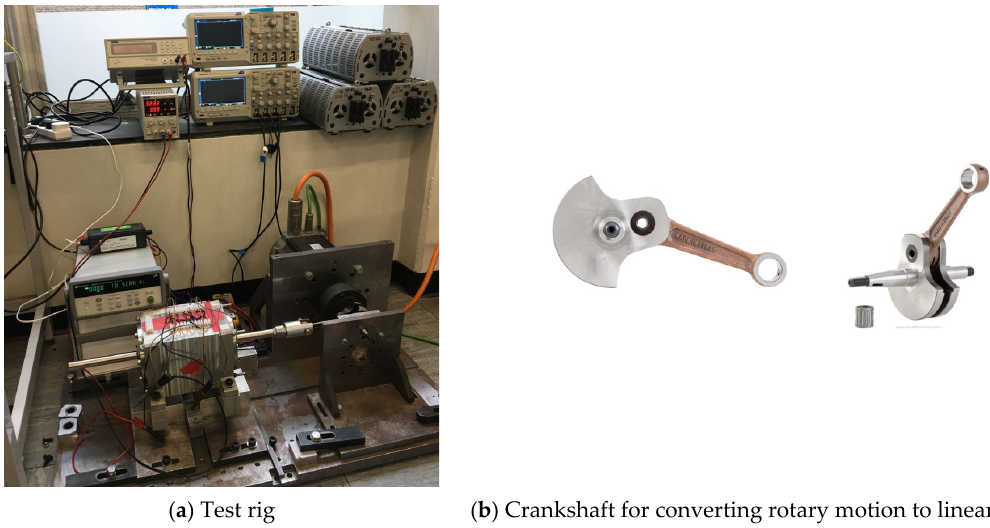
Figure 23. ( a )Test rig for the prototype machine. ( b ) Crankshaft . Figure 23. ( a ) Test rig for the prototype machine. ( b )